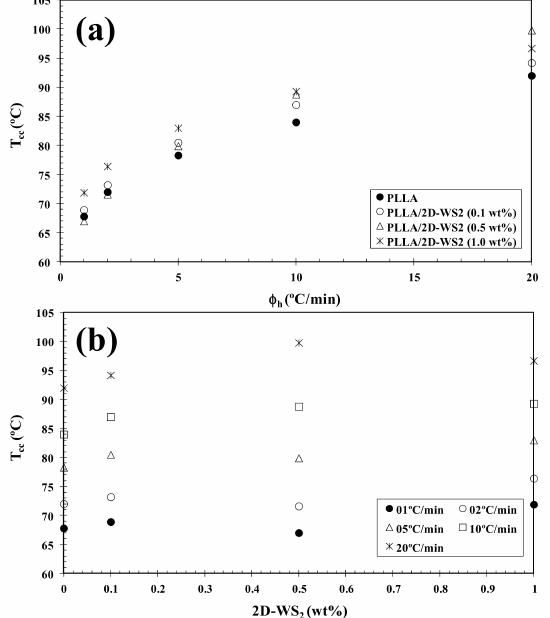
Figure 5. Variation of the melting crystallinity (1 − λ ) m of PLLA/2D-WS 2 nanocomposites with ( a ) heating rate and ( b ) 2D-WS 2 concentration; inset is the difference between the overall crystallinity change derived from the difference between endotherm and exotherm, ∆ (1 − λ ) = (1 − λ ) m − (1 − λ ) cc , for PLLA/2D-WS 2